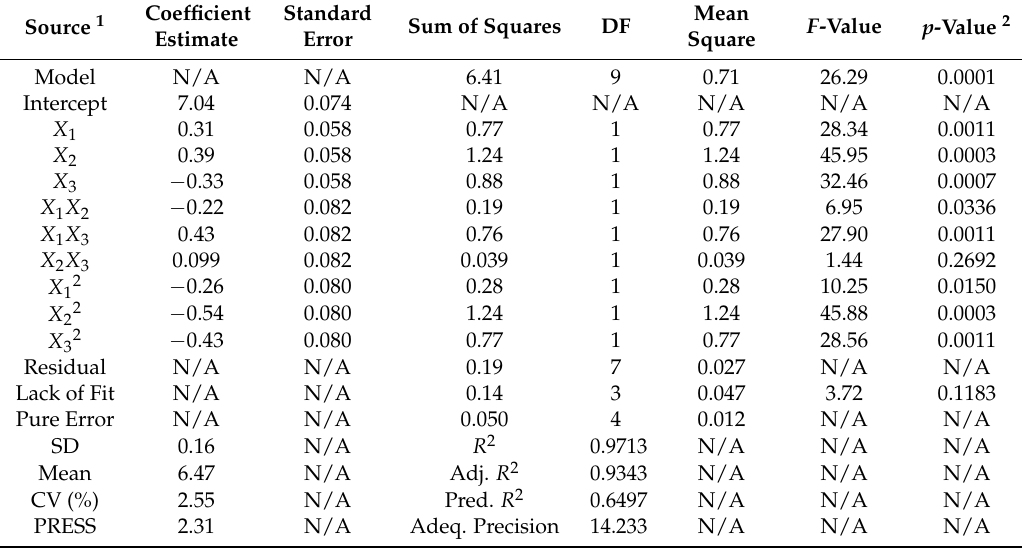
Table 1. Analysis of variance for the quadratic polynomial